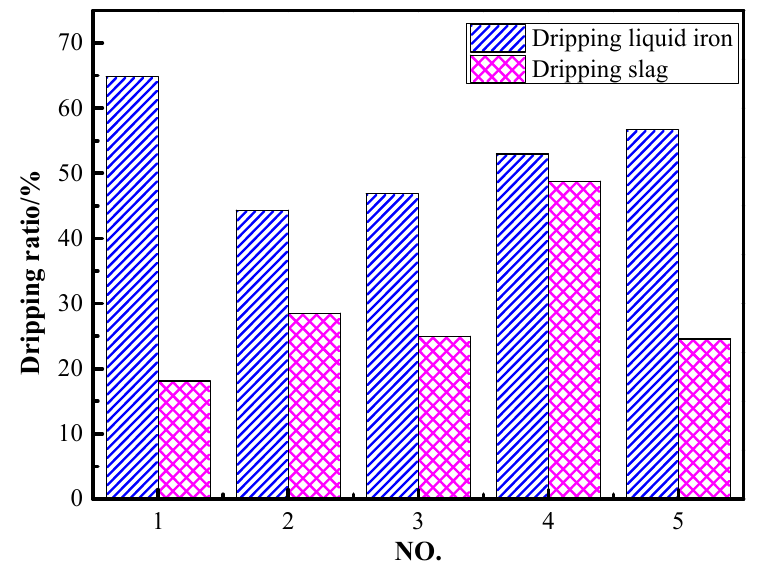
Figure 3. Dripping ratio of liquid iron and slag under different conditions.